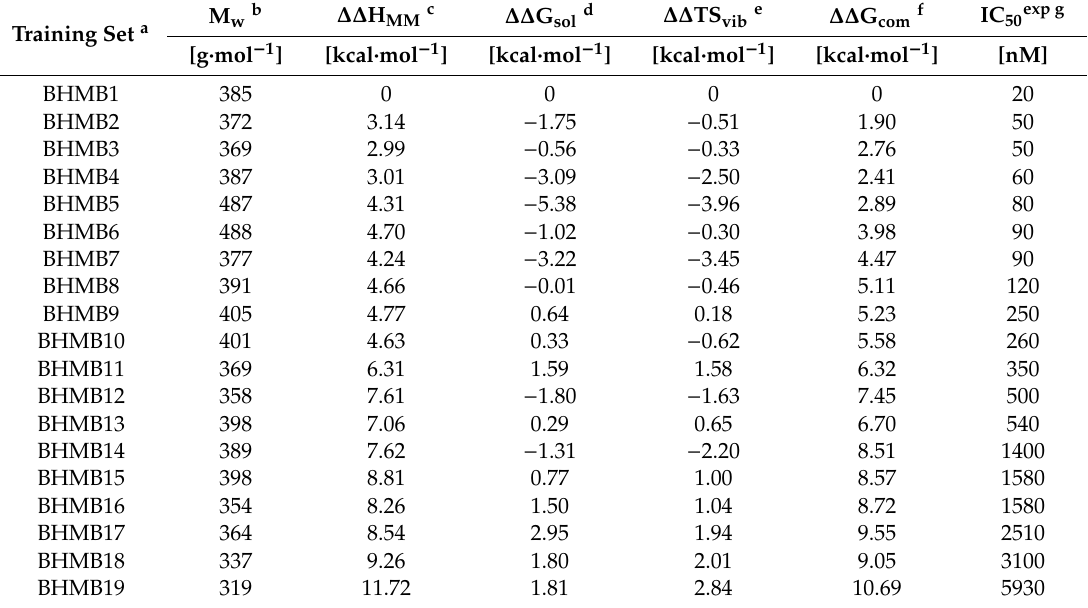
Table 2. Gibbs free energy (binding a ffi nity) and its components for the training set of InhA inhibitors BHMB1-19 and validation set inhibitors BHMV1-6